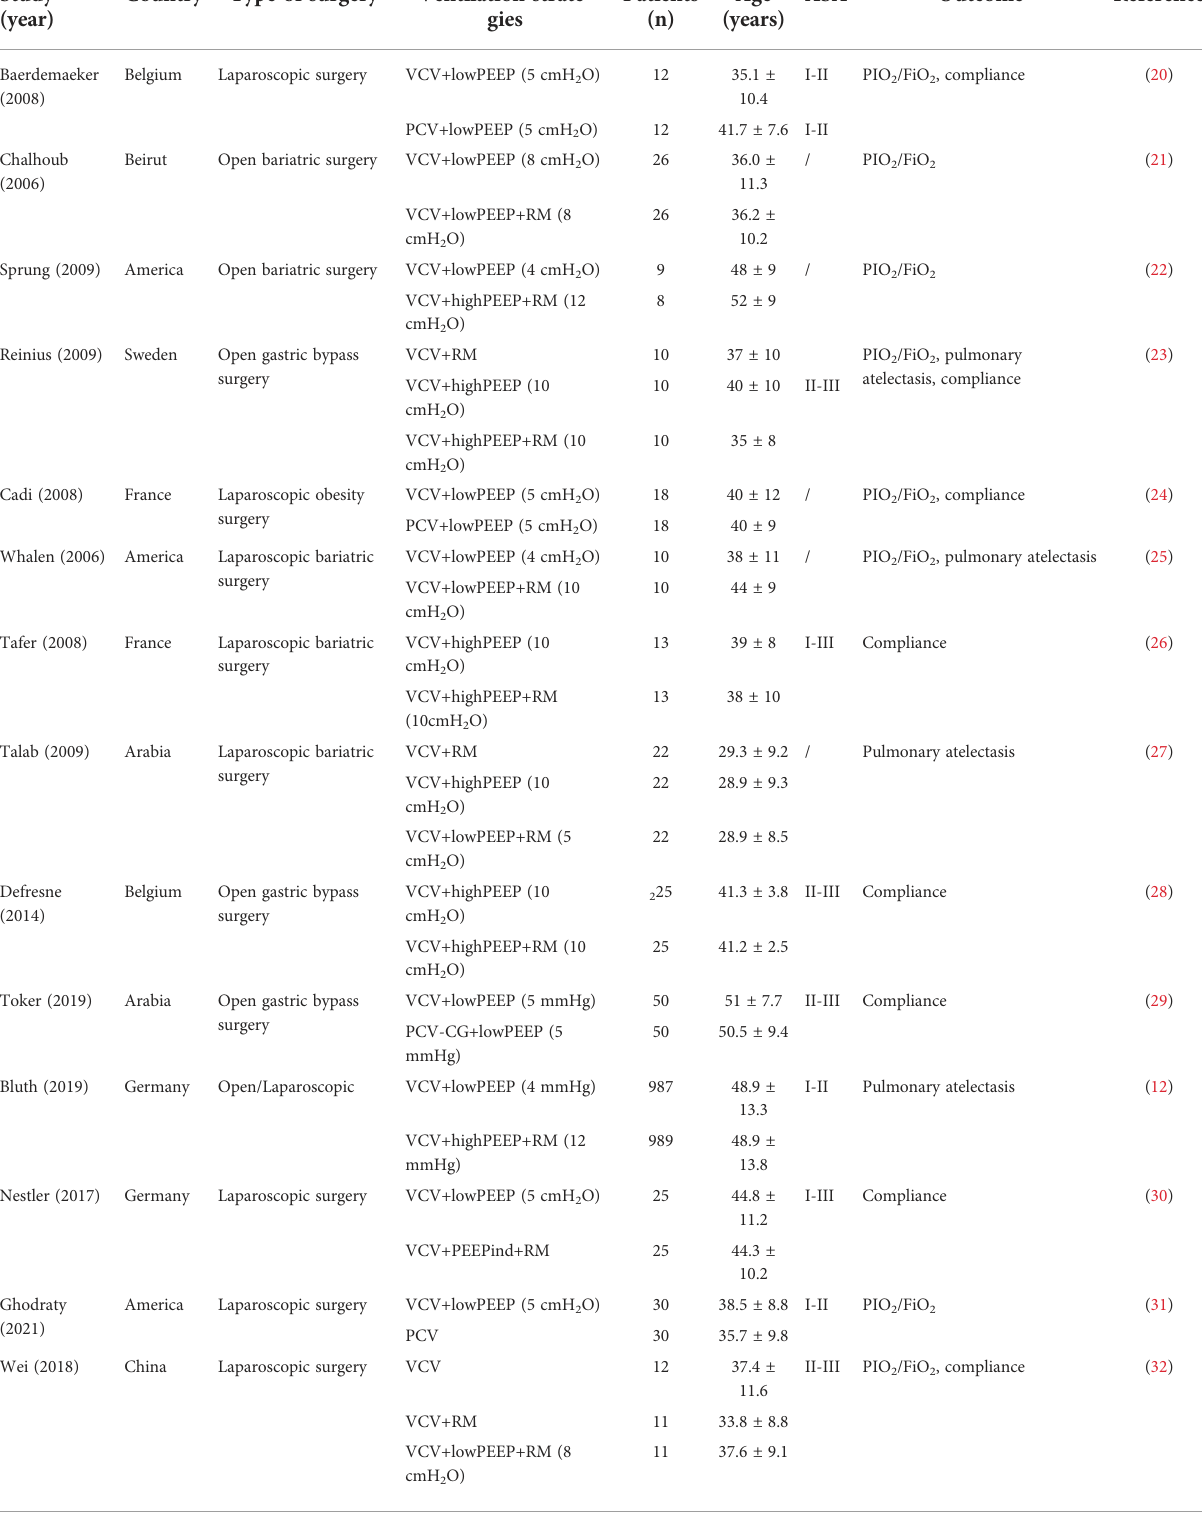
TABLE 1 Basic characteristics of the included